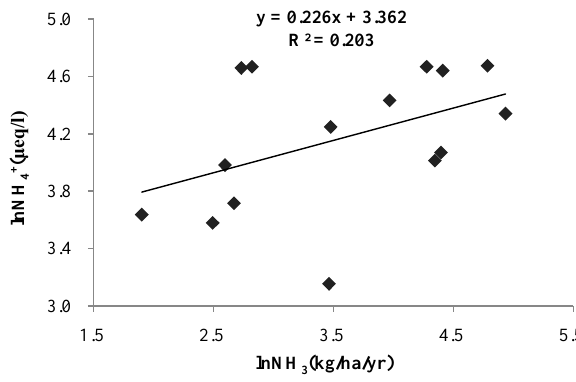
Fig. 10. Average chemical composition of precipitation in the PRD region, 2006.